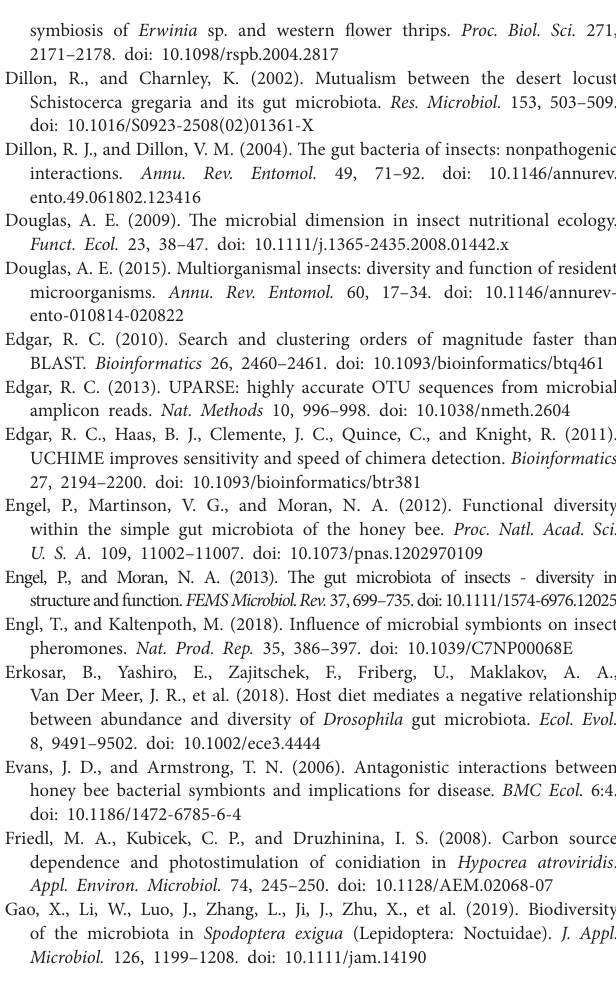
Supplementary Table 1 | Relative abundance of bacteria communities at the genus level in different group (Top 15). Supplementary Figure 1 | Alpha diversity dilution